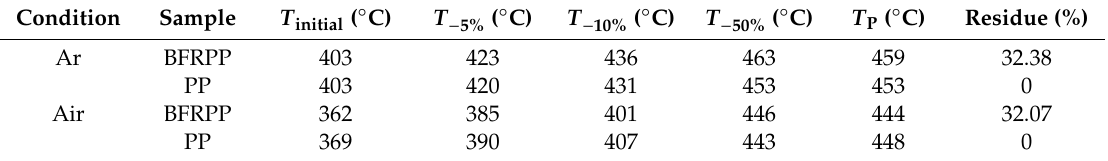
Figure 5. Thermogravimetric curves of samples: ( a ) TG curves; and ( b ) DTG curves. Table 2. Thermal decomposition characteristic parameters of PP and BFRPP